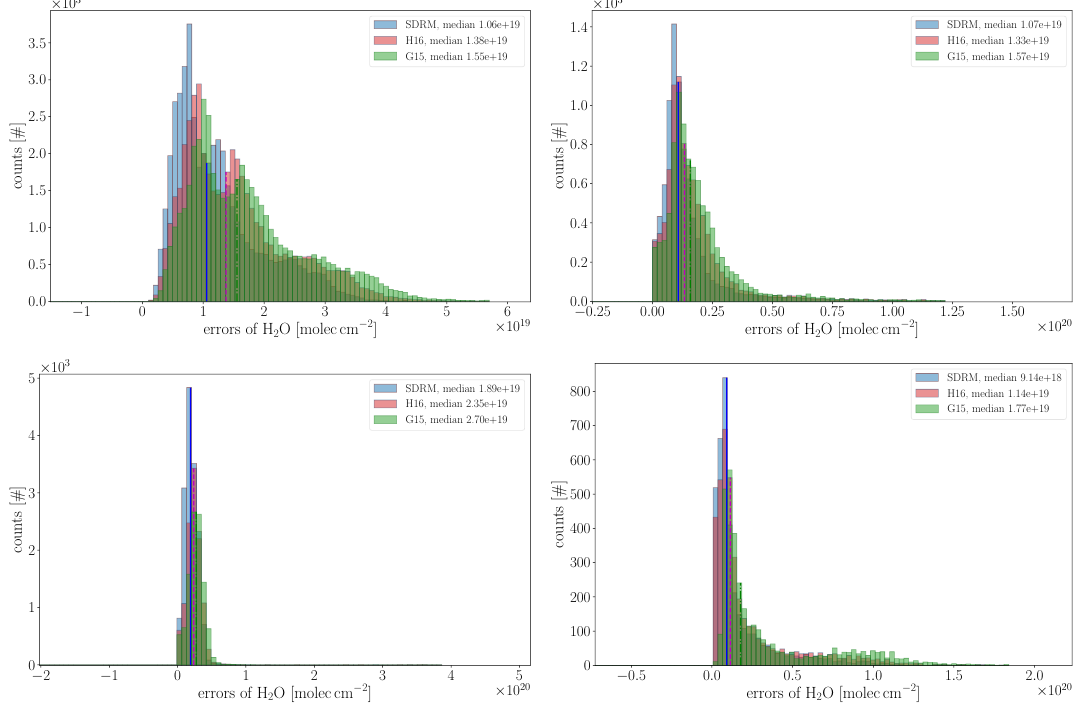
Figure A2. Errors of H 2 O columns for Sahara, Central-Europe, Amazonia and Siberia (clockwise from